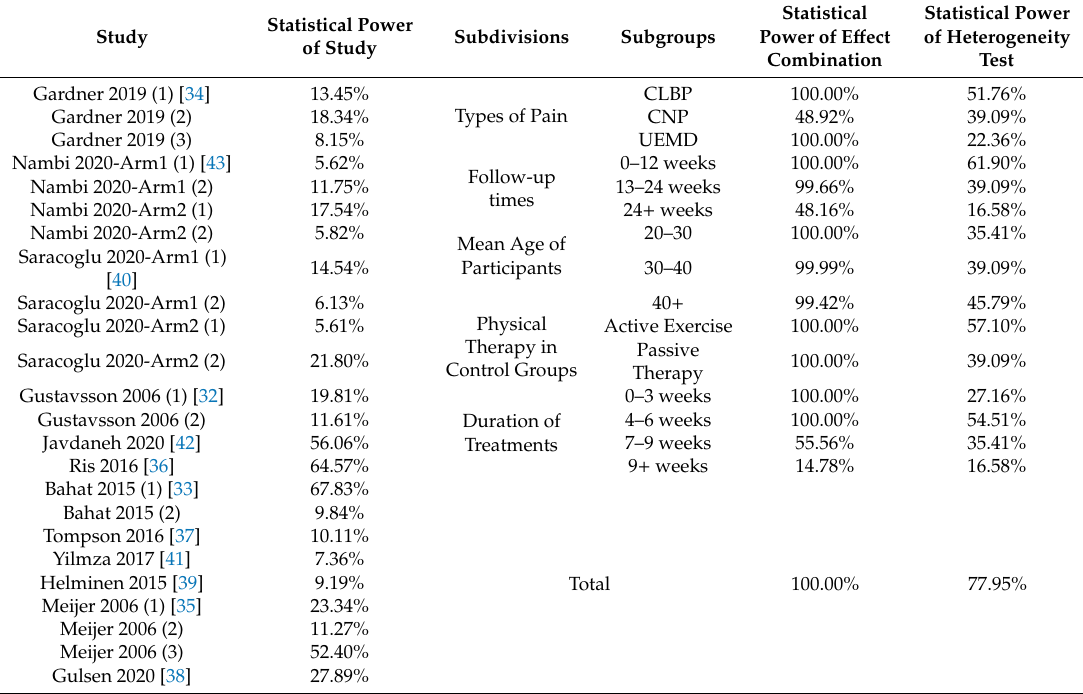
Table 7. The result of statistical power test of all included studies and